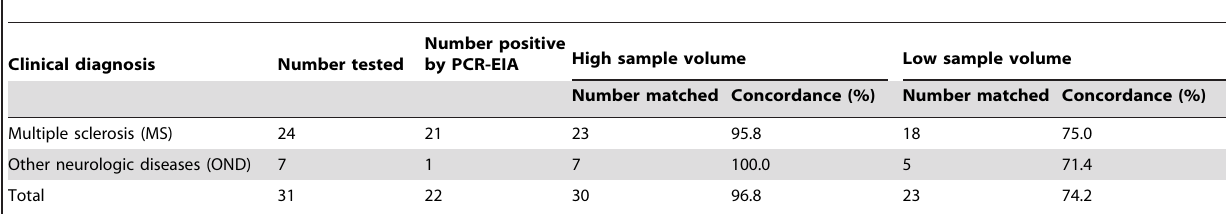
Table 2. Test reproducibility of PCR-EIA is related to extract volumes included in the PCR reaction mixture.